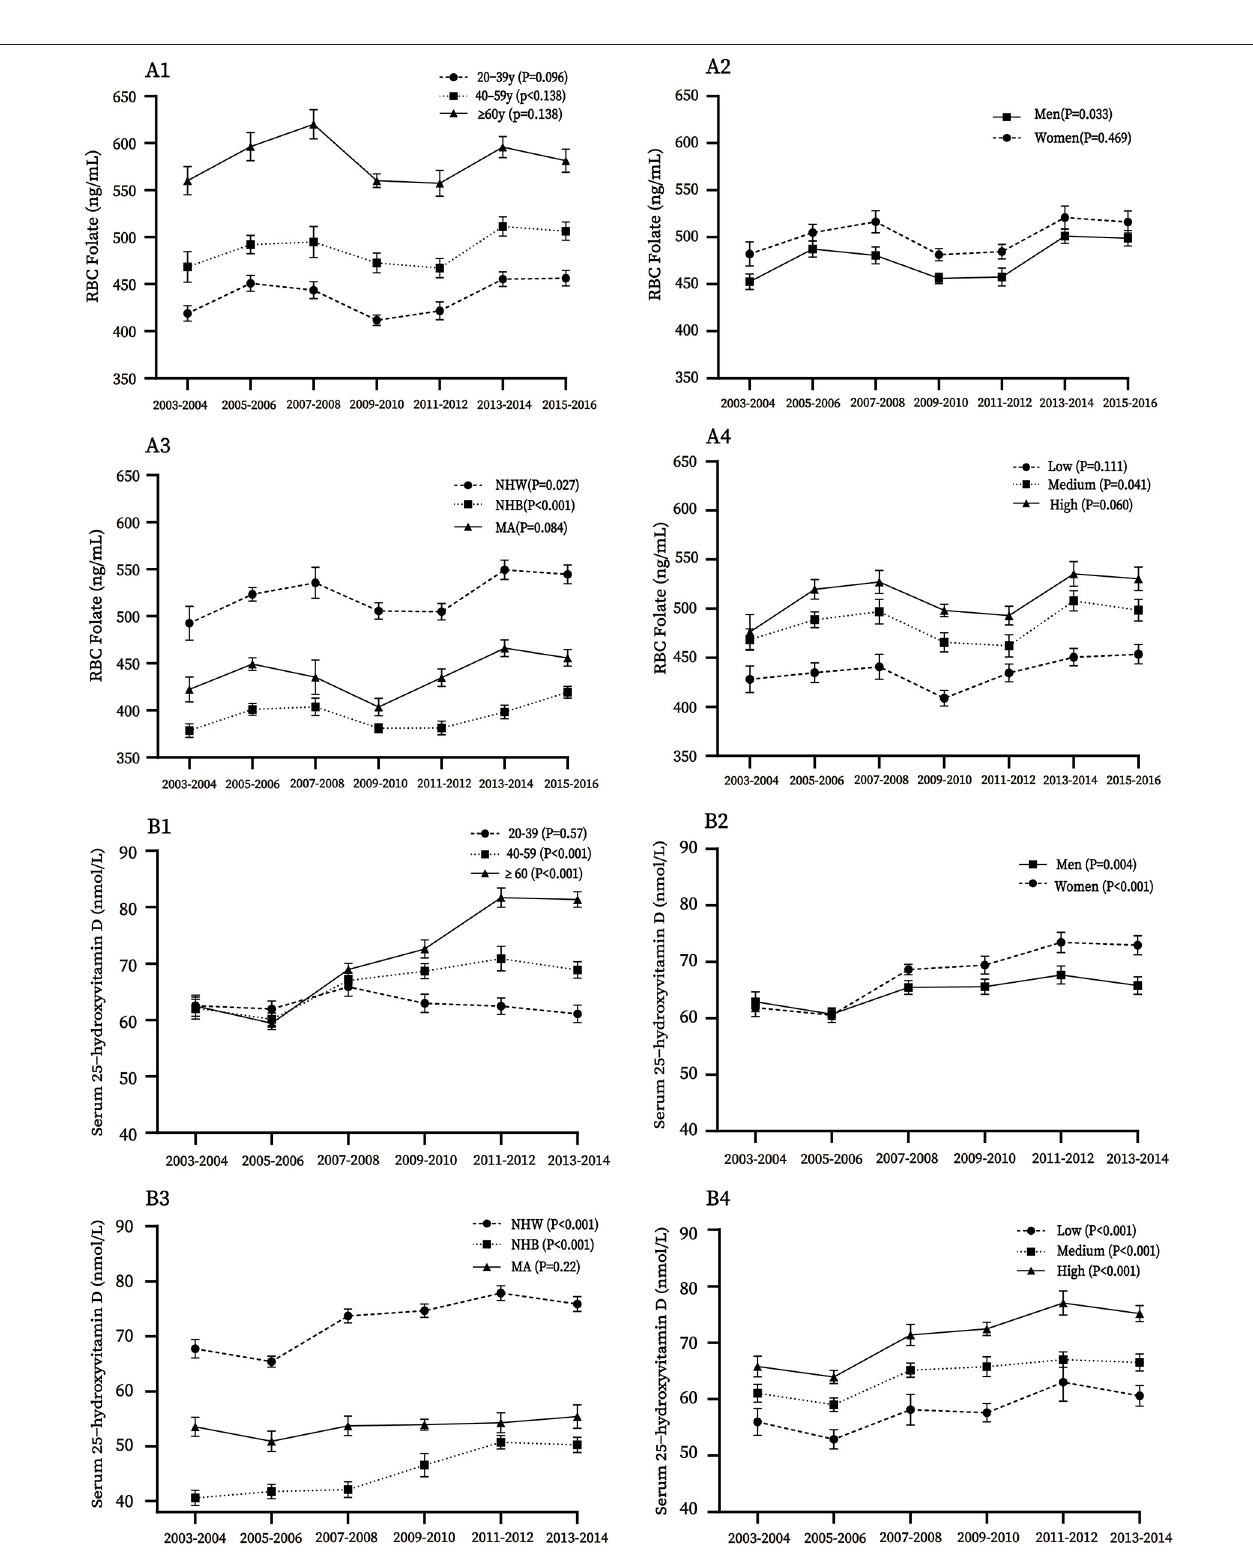
FIGURE 1 | Trends of concentrations of RBC folate (A1–A4) and 25-hydroxyvitamin D (B1–B4) by age, sex, race-ethnicity, and socioeconomic status (SS) among US adults from 2003 to 2016. MA, Mexican American; NHW, non-Hispanic white; NHB non-Hispanic black.